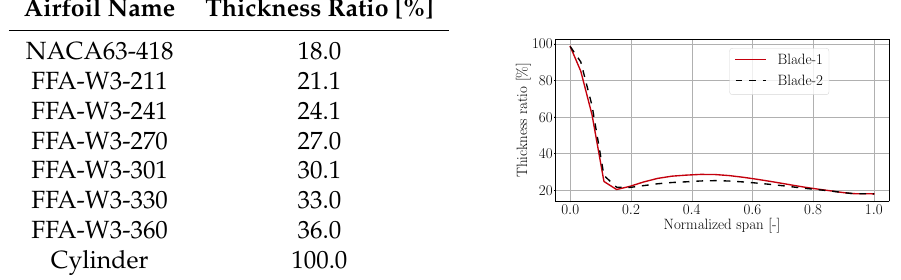
Figure 2. The airfoils and the thickness ratio used in blade designs are shown in the left and the blade thickness ratio over the normalized span is shown in the